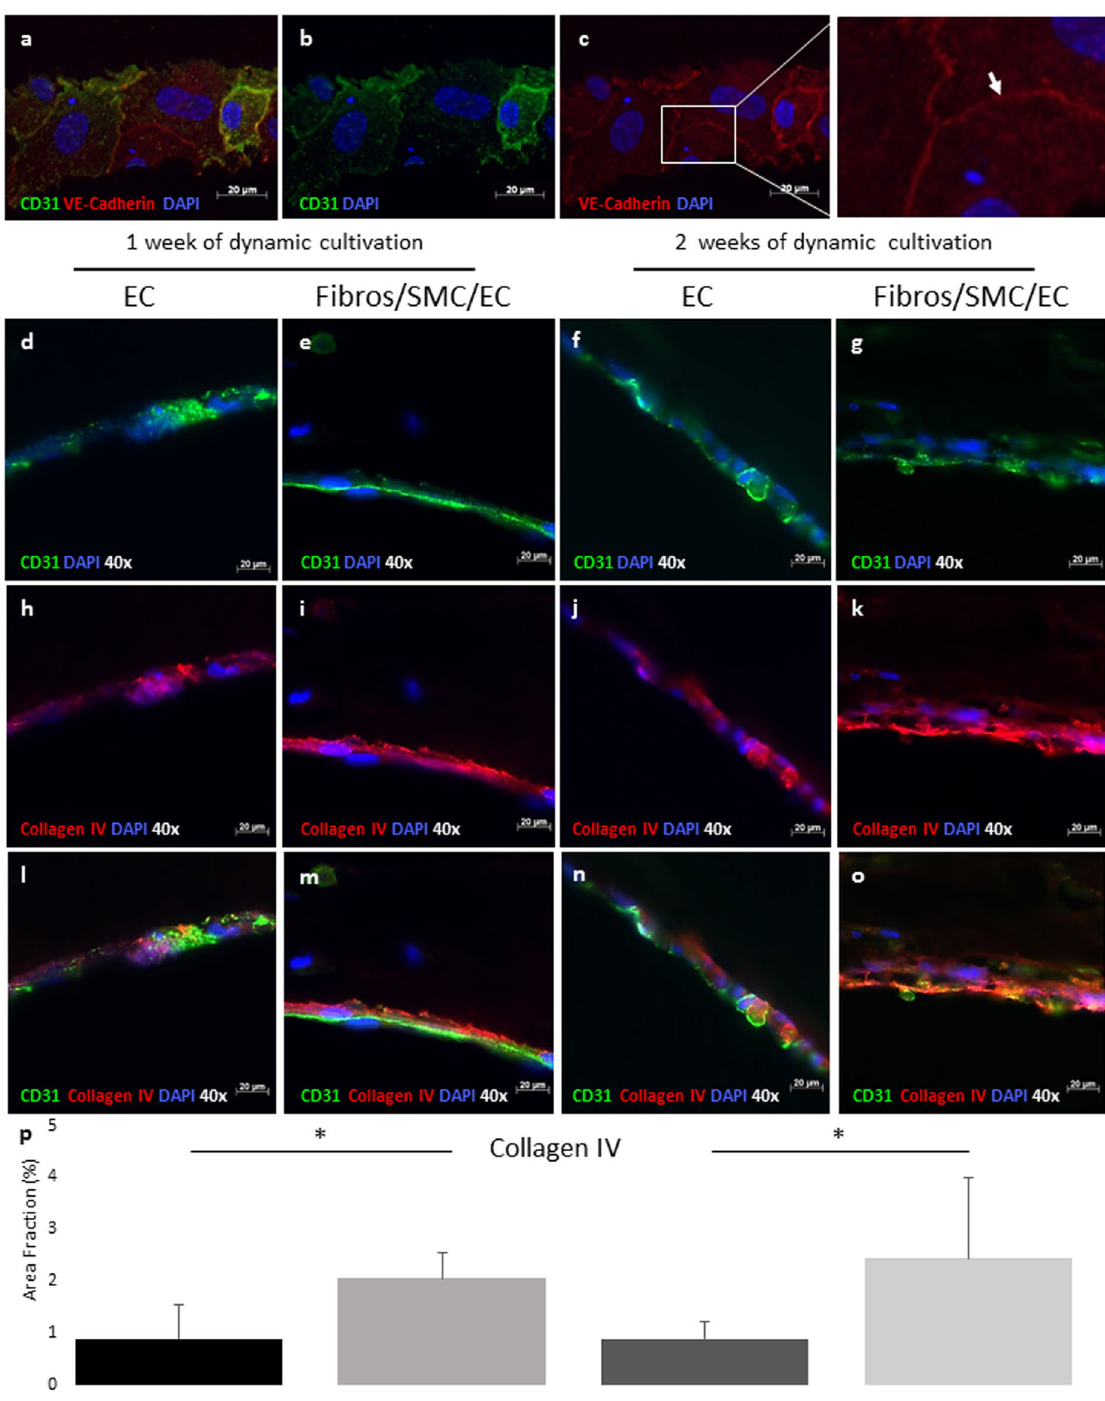
Figure 6. Fluorescence micrographs of the endothelium in sections, qualitative and quantitative assessment of collagen IV expression. Confluent layer of Endothelial cells (EC) at the channel wall after 21 days of flow reveals the expression of VE-Cadherin at the intercellular junctions (white arrow) ( a – c ) (CD31 in green, VE-Cadherin in red, DAPI in blue, 40x). Representative fluorescent microscopy images of single channel cross sections reveal increased production of collagen IV after both one and two weeks of dynamic cultivation for the channels lining a single layer of EC ( d , f , h , j , l , n ) in comparison to the complete multi-layered structures ( e , g , i , k , m , o ) (CD31 in green, collagen IV in red and DAPI in blue, 40x). A statistically significant increase ( * p < 0.05) in the production of collagen IV was also shown by the quantification of collagen IV area fraction ( p